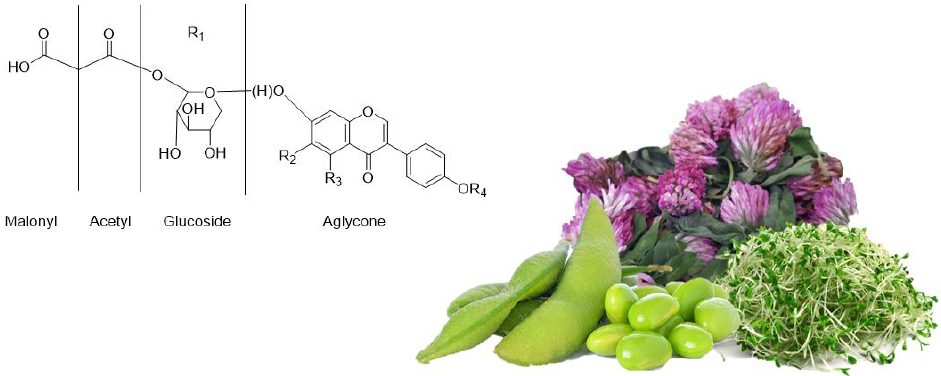
Figure 3. Chemical structure of isoflavones from Fabaceae family plants (alfalfa, red clover and soy).